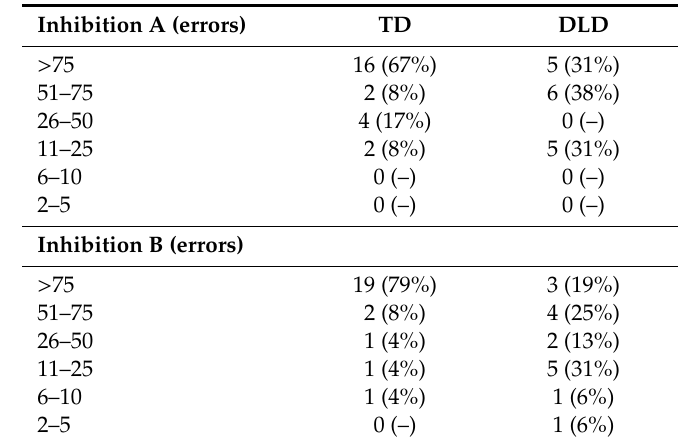
Table 3. Scalar scores obtained by the two groups of participants on the inhibition test of the NEPSY-II (Parts A and B, respectively). The number of participants having a specific scalar score for each group is presented together with